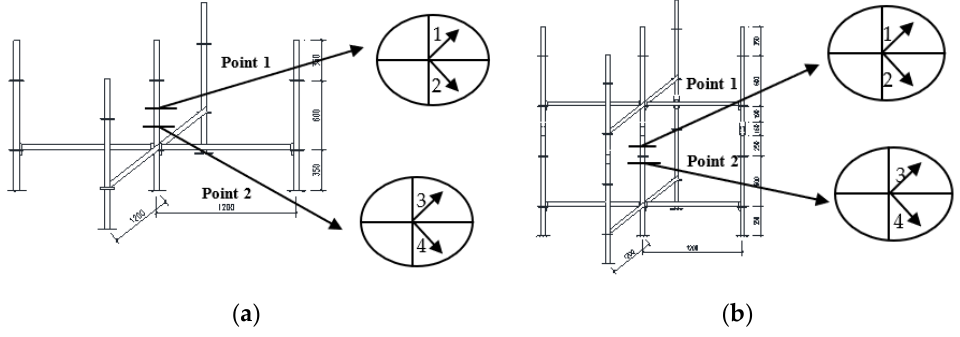
Figure 24. Measuring point arrangements: ( a ) Single-layer experiment; ( b ) double-layer experiment.